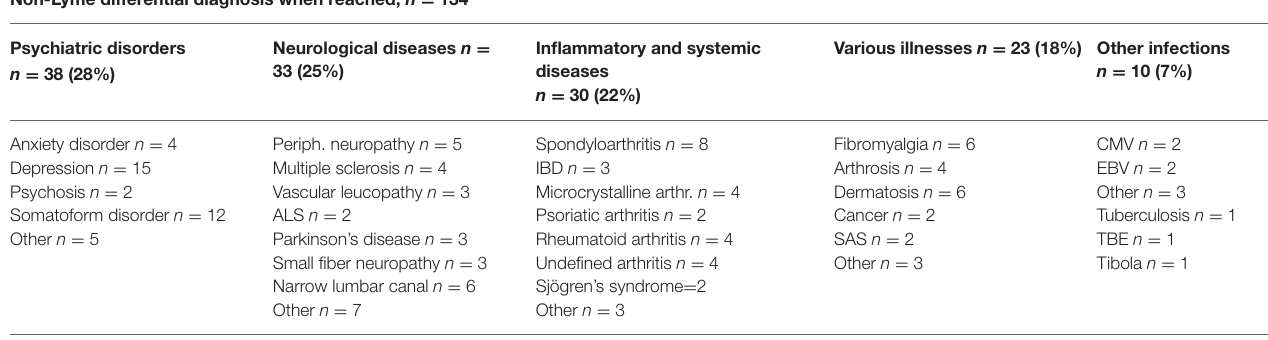
TABLE 4 | Alternative diagnosis when achieved. Non-Lyme differential diagnosis when reached, n = 134